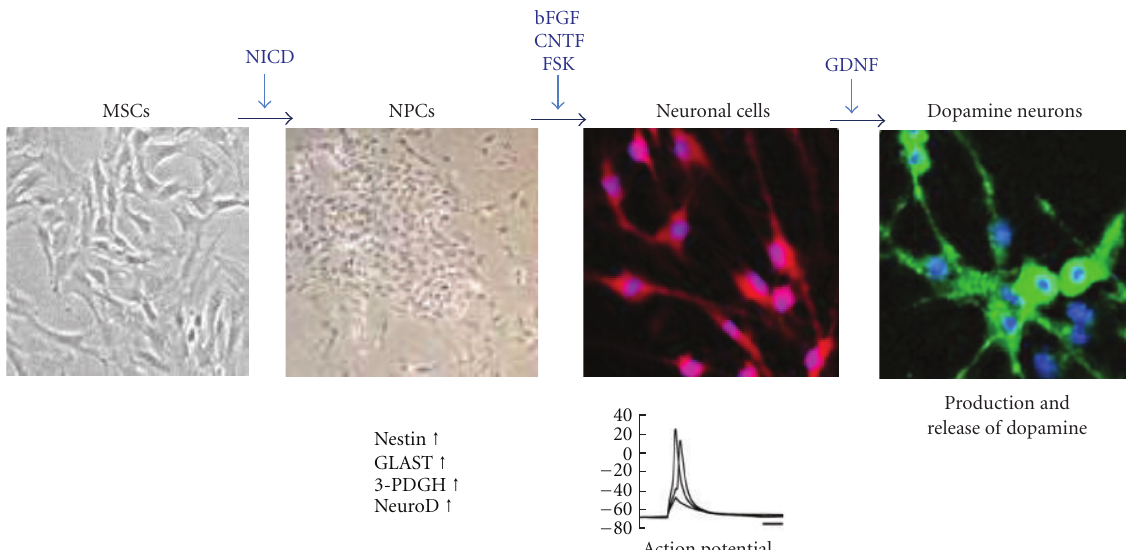
Figure 2: Induction of dopamine neurons from MSCs. After NICD introduction, MSCs become similar to NPCs, expressing the NPC markers nestin, GLAST, 3-PDGH, and neuroD. After cytokine stimulation (bFGF, CNTF and forskolin (FSK)), cells become postmitotic neurons expressing neuronal markers such as neurofilament, Tuj-1, and MAP-2. The administration of GDNF induces neurons to become dopamine neurons (TH), which are useful in the Parkinson’s disease model. Pictures from J Clin Invest 113 (2004) 1701–1710 and J Cereb Blood Flow Metab 29 (2009) 1409–1420 [17,